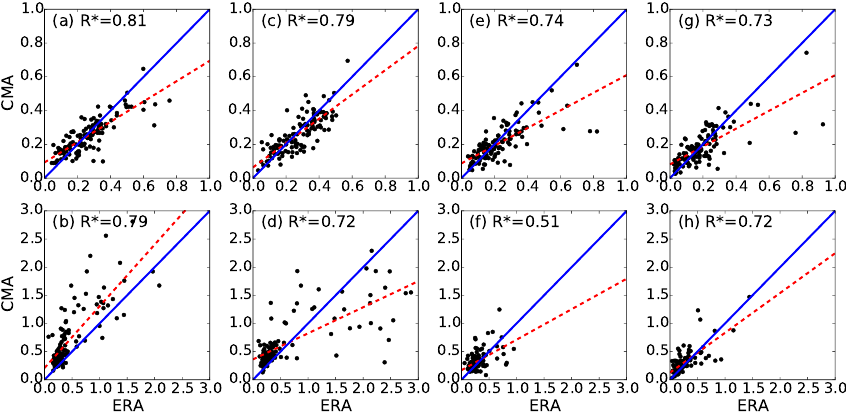
Figure 6. Scatter plots of the seasonally averaged CMA-BLH and ERA-BLH at (top) 08:00 and (bottom) 20:00BJT in (a, b) spring, (c, d) summer, (e, f) fall and (g, h) winter. The correlation coefficients ( R ) are given in each panel, where the star superscripts indicate that values are statistically significant ( p <